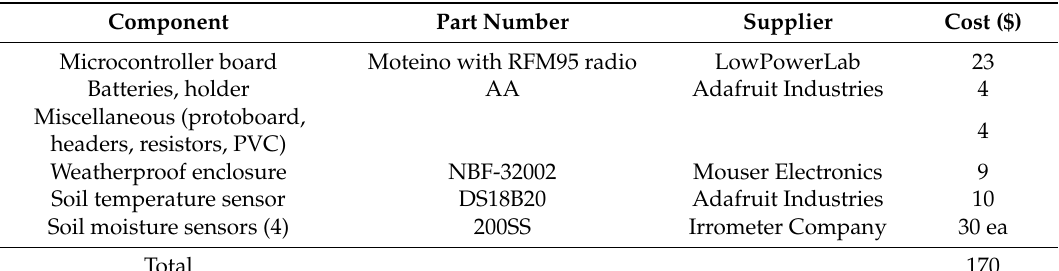
Table 1. List of materials for soil moisture monitoring system sensor